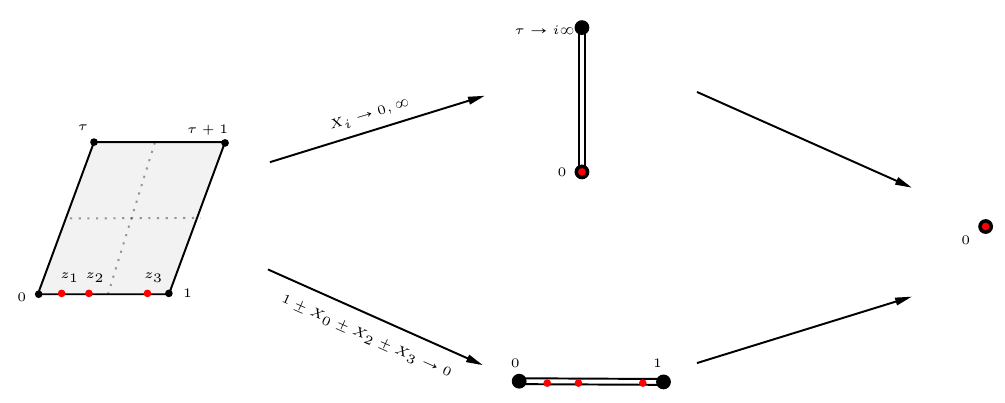
Figure 5 . Degenerations of the toric geometry near the differential equation simple